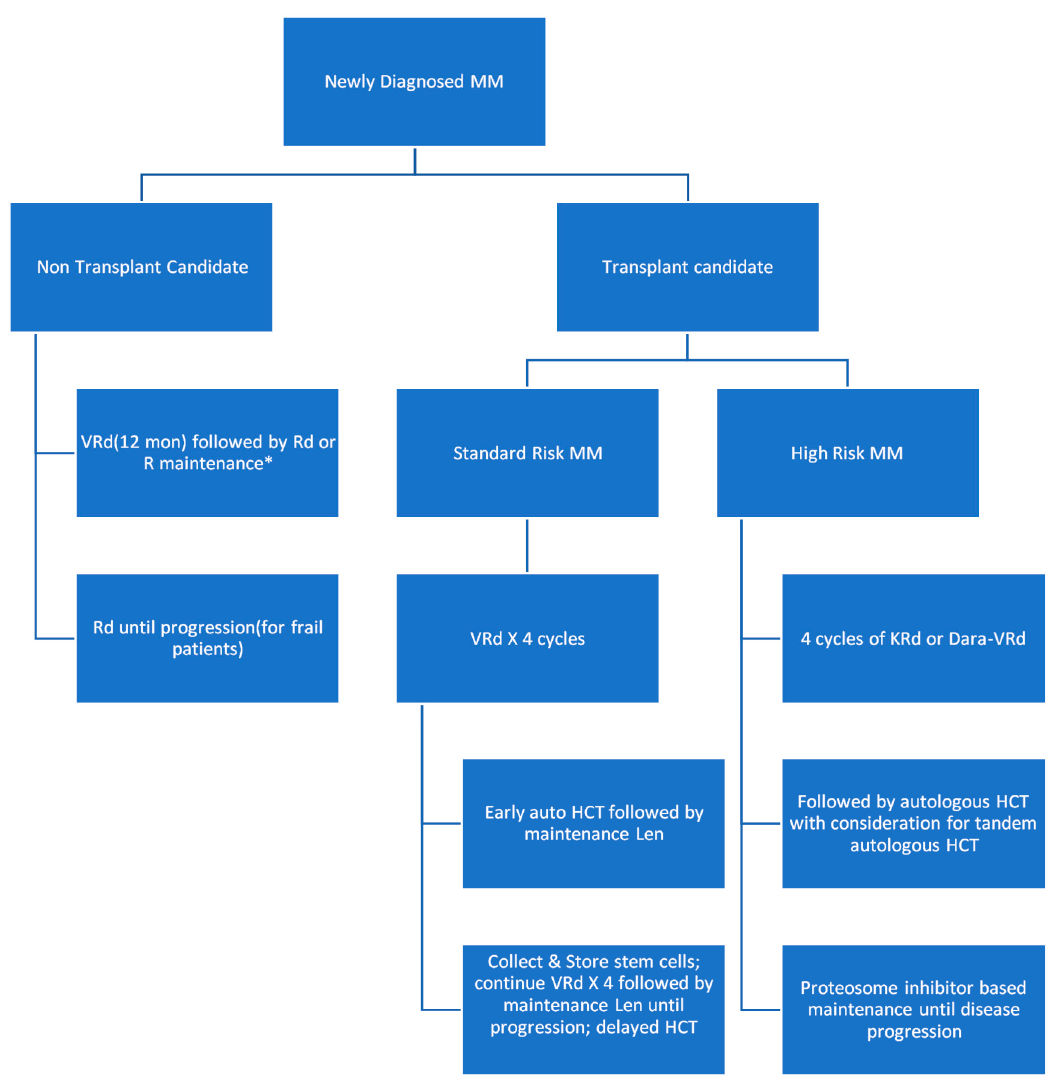
Figure 7. Modified flow chart depicting the general outline of treatment options for MM adopted from mSMART.org. HCT: hematopoietic stem cell transplantation.